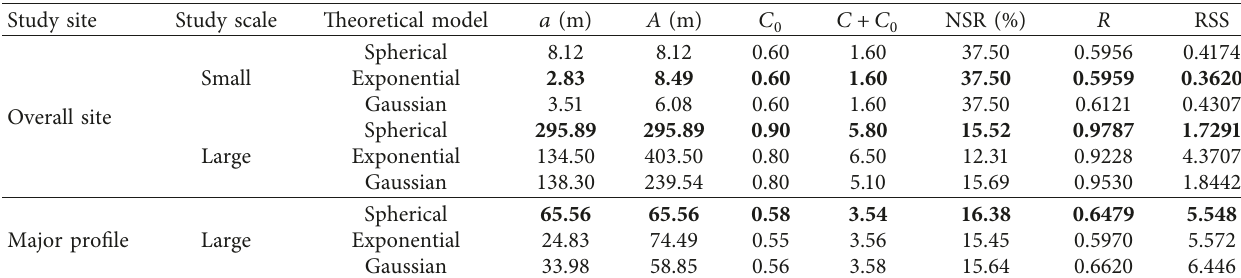
Figure 6: Omnidirectional variograms of the estimated ln K K s values: (a) the small-scale variogram for ln s for the overall site; (b) the large- scale variogram for ln K s for the overall site; (c) the large-scale variogram for ln K s for the major cross section. Table 2: Parameters of fitting theoretical variogram models for the ln K s